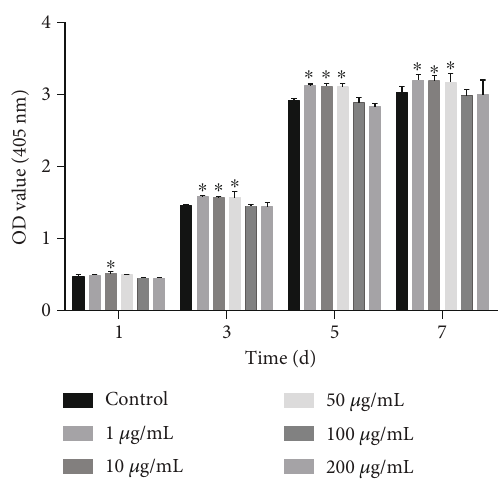
Figure 2: The proliferation of SHEDs incubated with di ff erent concentrations (0, 1, 10, 50, 100, and 200 μ g/mL) of GOQDs for 1, 3, 5, and 7 days. ∗ p < 0 : 05 vs. the control group.